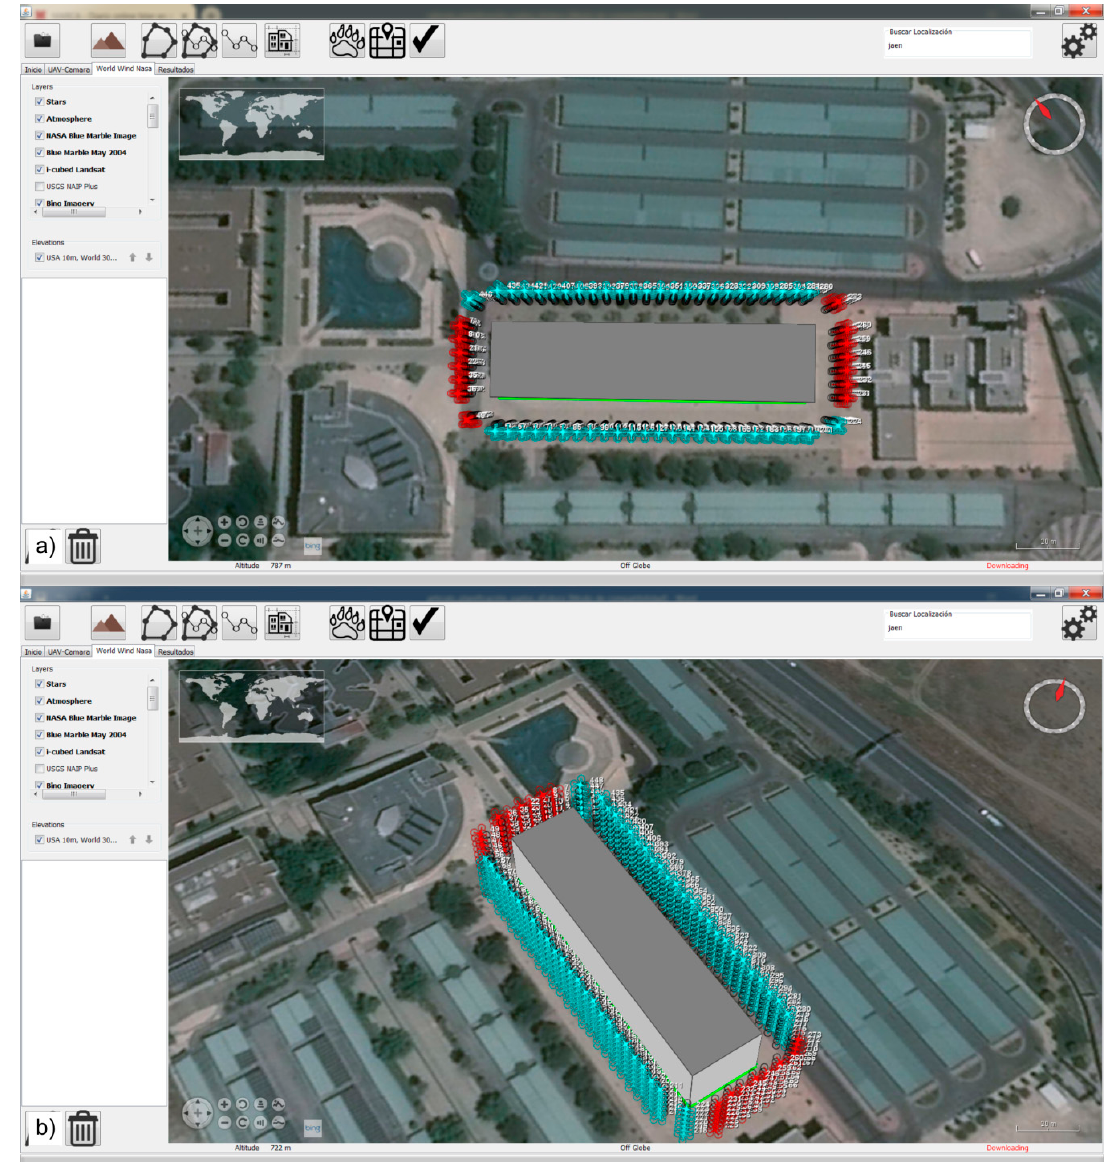
Figure 8. Example of polygon extrusion flight.